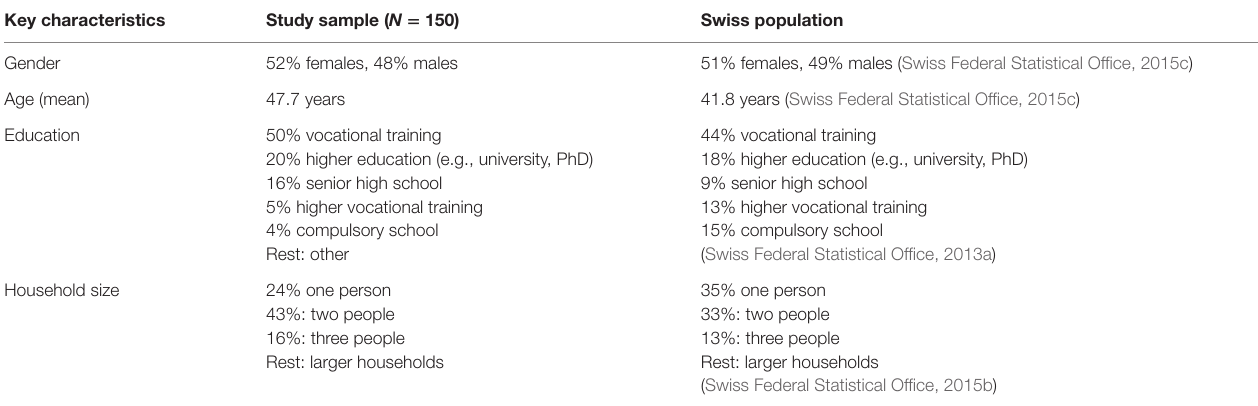
TaBle 3 | Key characteristics of our sample in comparison with swiss population statistics. Key characteristics